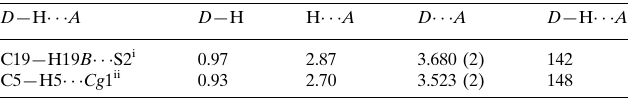
Hydrogen-bond geometry (A˚ , (cid:1)